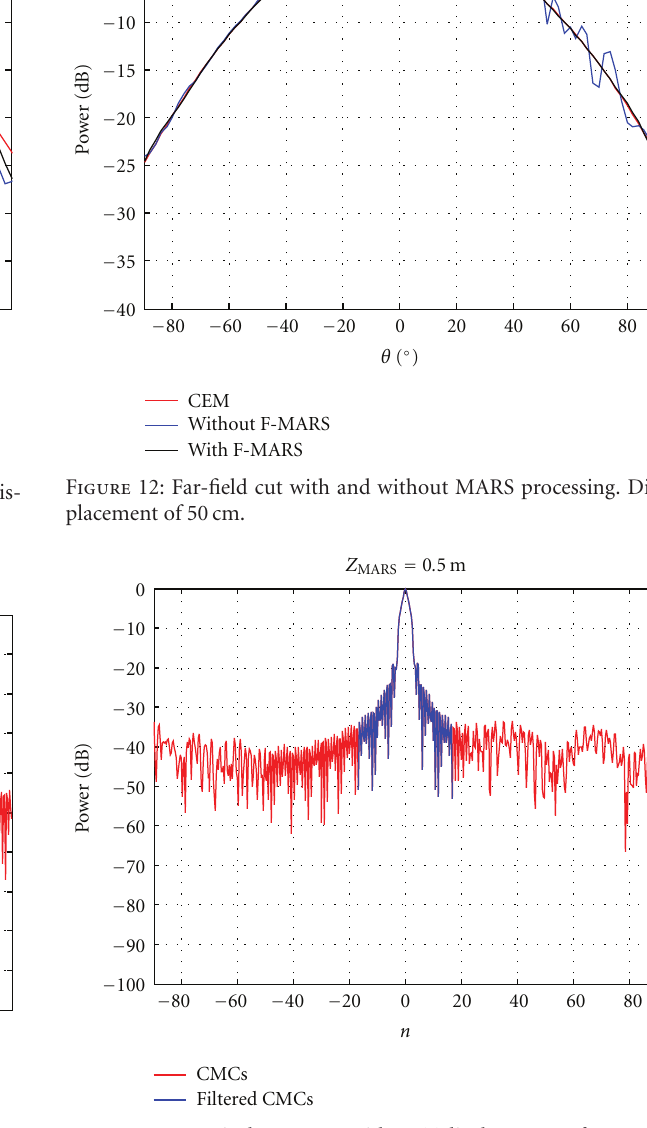
Figure 13: Equivalent CMCs with AUT displacement of